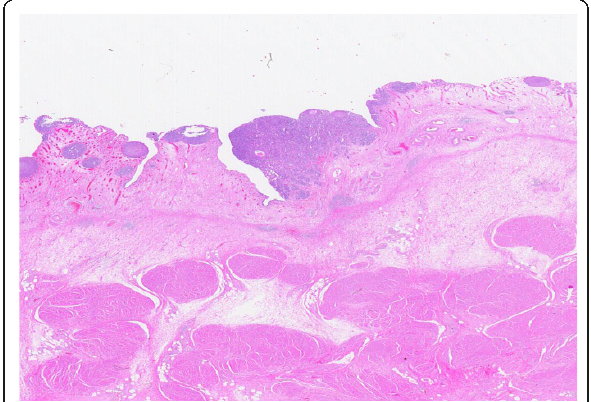
Figure 12 Urothelial carcinoma with lamina propria invasion .